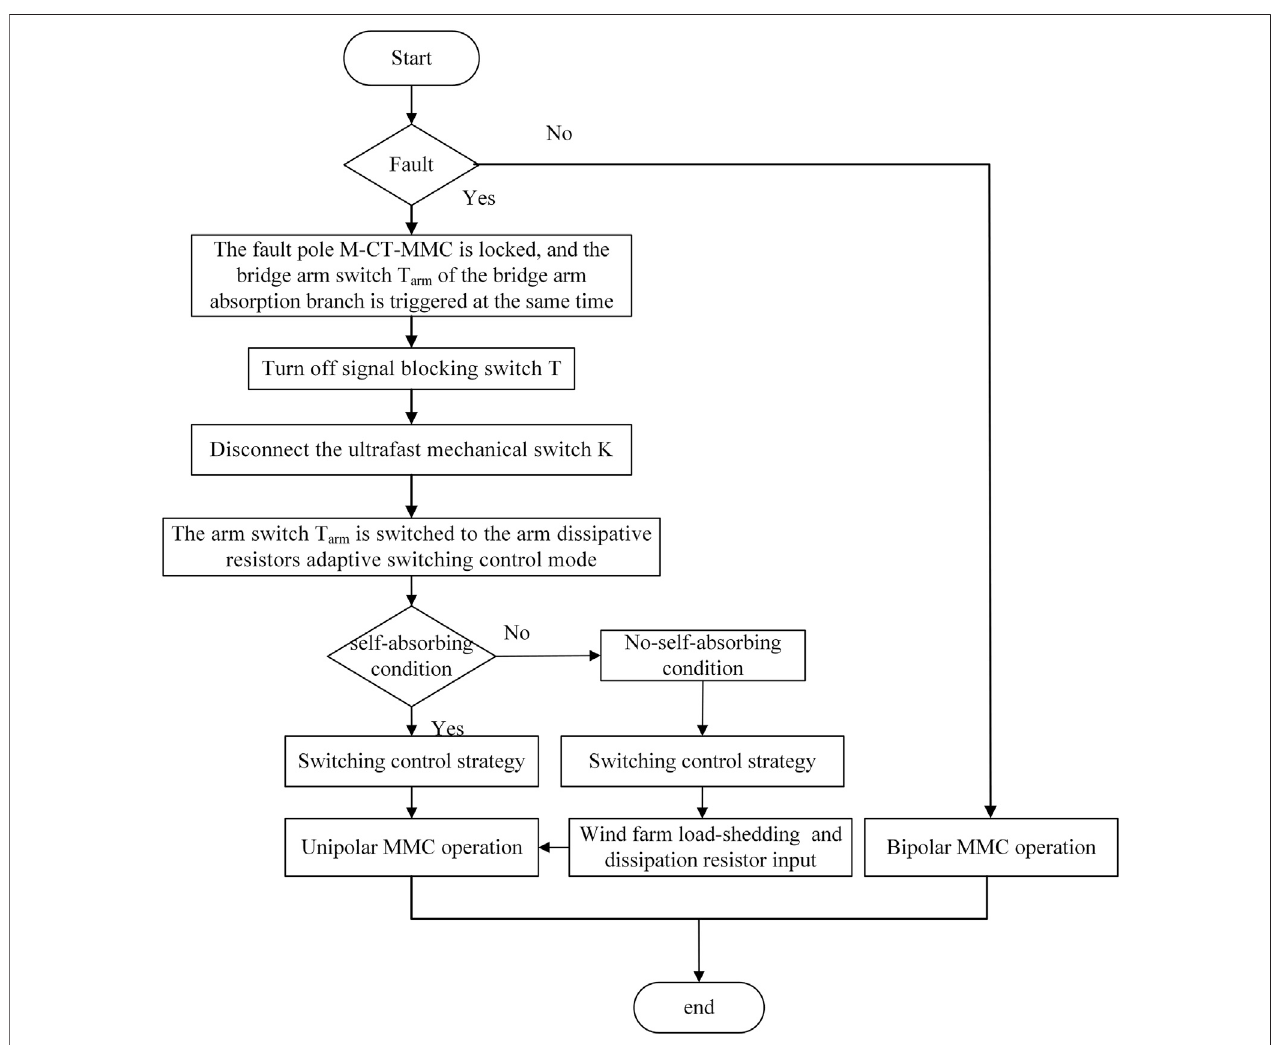
FIGURE 3 | Fault ride-through fl ow block